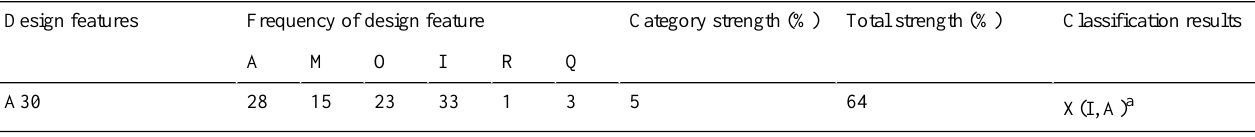
Table 5. Categorizing design features by the total sample (n=103).